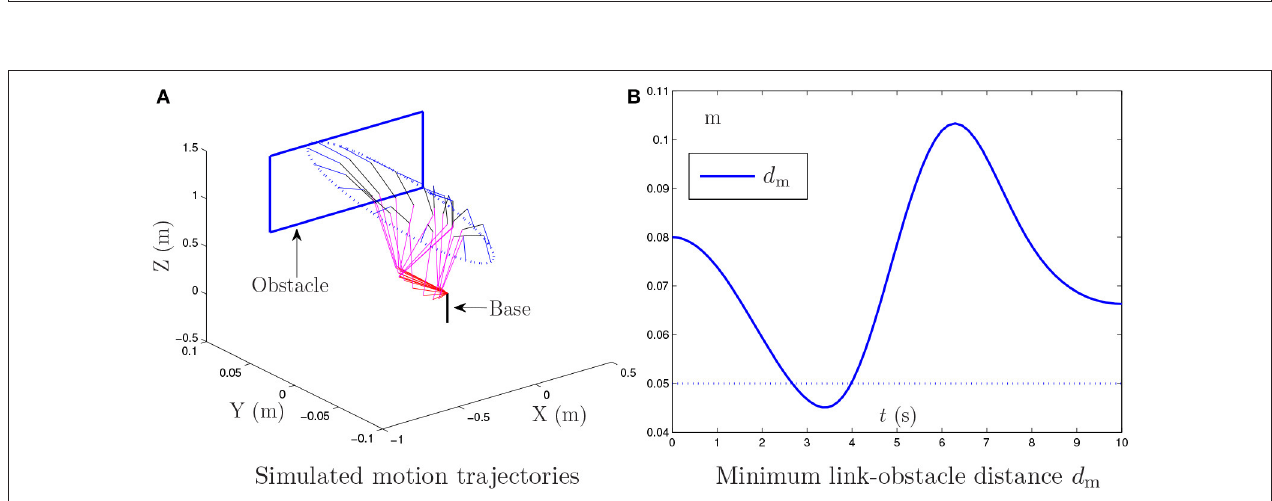
FIGURE 6 | Simulation results synthesized by the general MVN scheme for the PA10 end-effector tracking the circular path, where the existence of the window-shaped obstacle and noise is not considered.